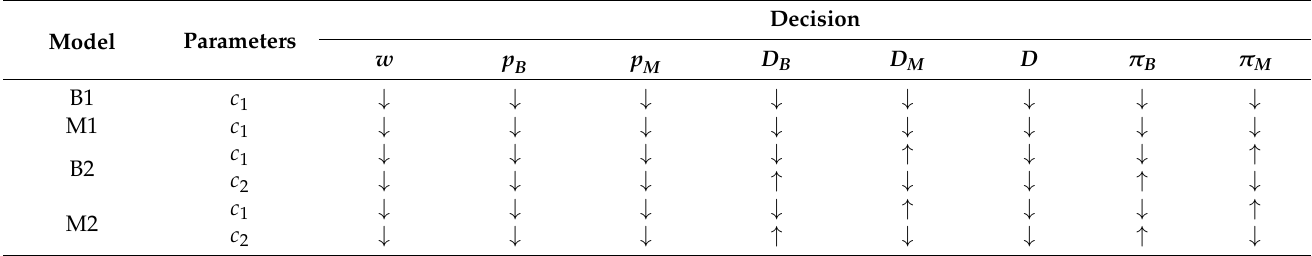
Table 2. The influence of unit processing cost c 1 , c 2 on equilibrium decisions under four models.